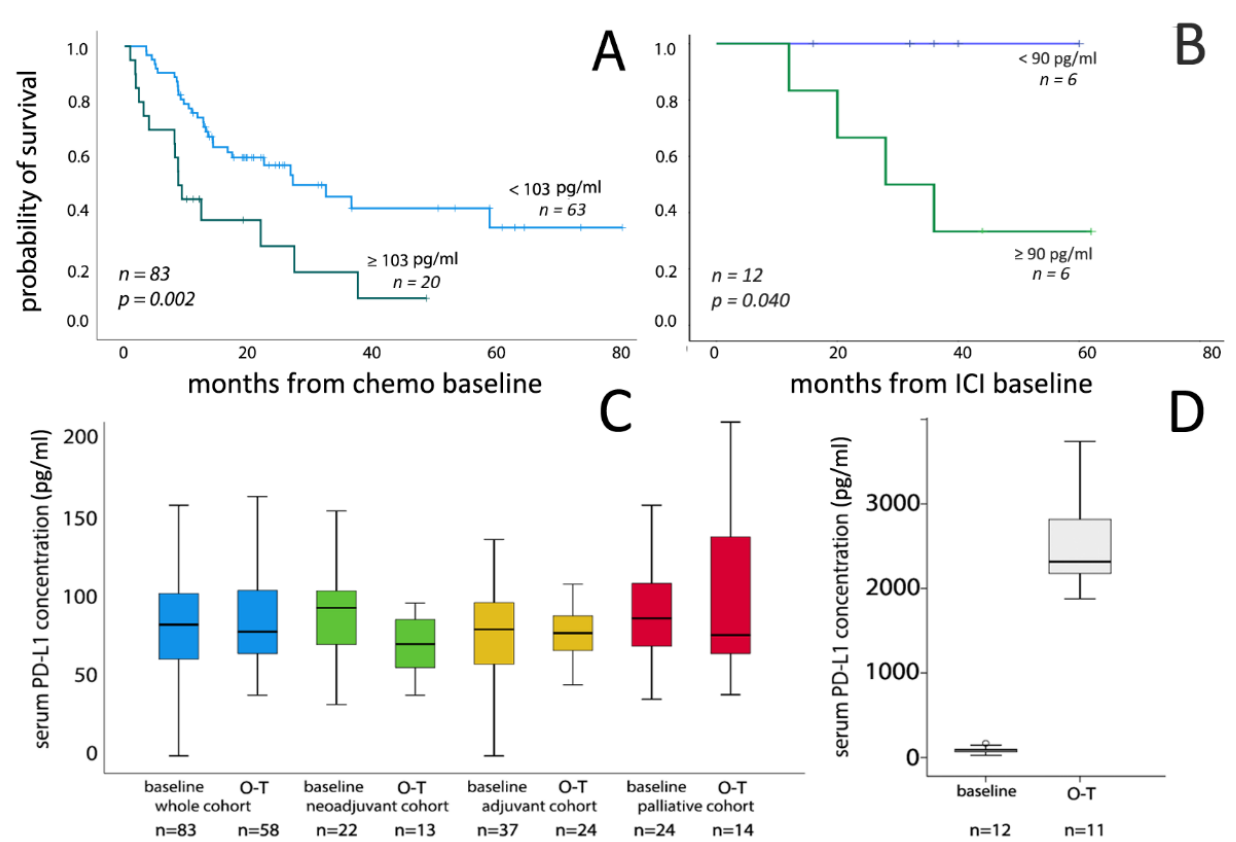
Figure 1. Overall survival stratified by pretreatment sPD-L1 levels in the chemotherapy ( a ) and ICI-treated patients ( b ). Box-plot presentation of serum PD-L1 levels in pretreatment and follow-up samples (collected at 2-3. therapy cycles) in platinum-treated ( c ) and immune checkpoint inhibitor-treated ( d ) bladder cancer patients. Please note the strong increase of sPD-L1 levels in on-treatment (O-T) serum samples taken during ICI therapy. Table 3. Cox uni- and multivariate OS analysis in platinum-treated patients.